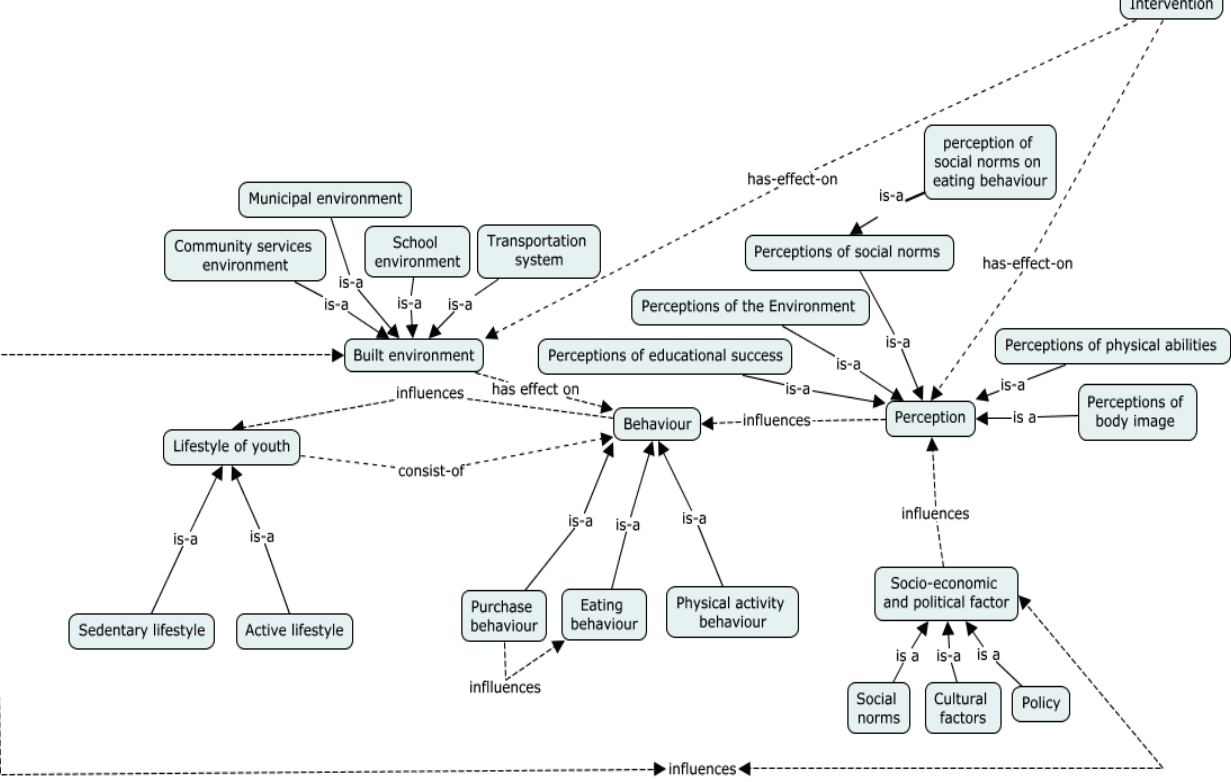
Figure 5. Conceptual Mapping (note that the solid lines represent subsumption (is-a) relationships, while dashed lines demonstrate associative relations (e.g., x influences y)).